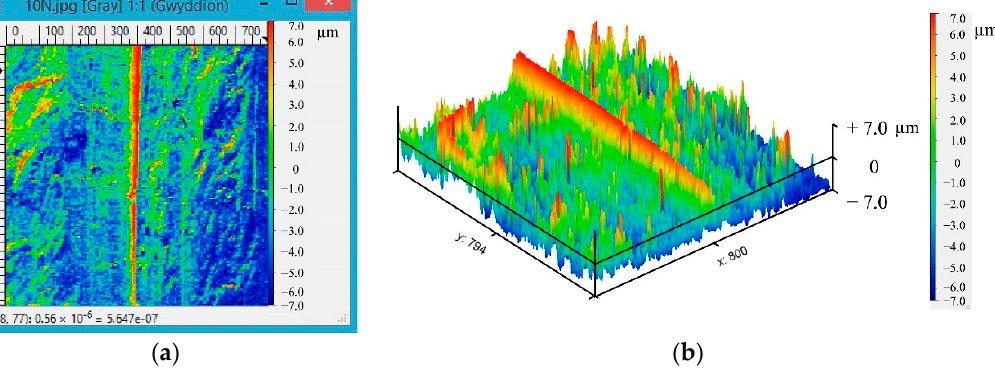
Figure 12. The area of the surface that was processed when applying LCLo: 2D ( a ) and 3D ( b ) images of the surface.